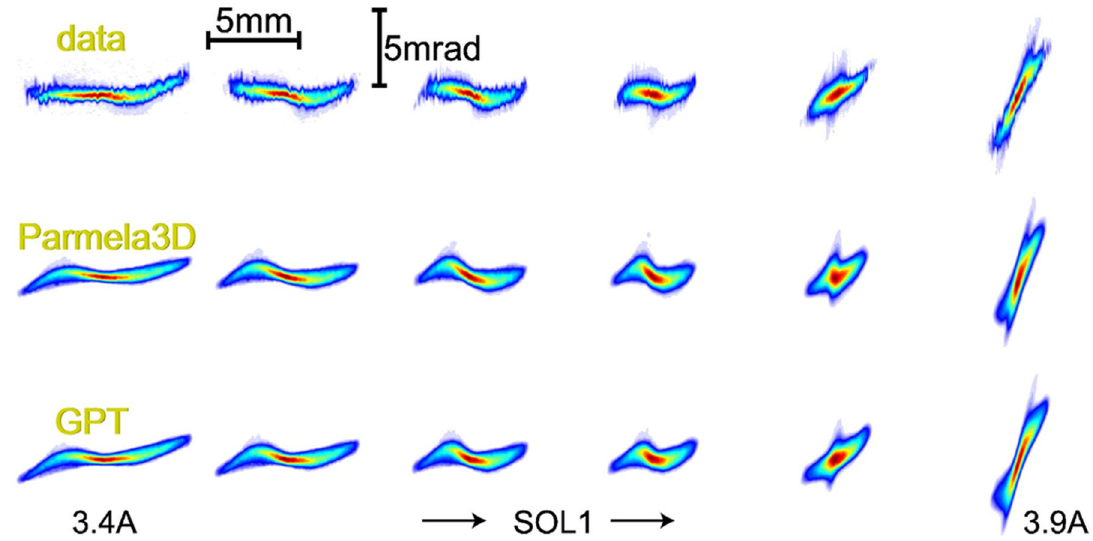
FIG. 14. (Color) Comparison of measured and simulated vertical transverse phase space distributions for 20 pC bunches at z ¼ 1 : 244 m . Data representing measurements, PARMELA3D , and GPT calculations are arranged in rows with different strength of the solenoid lens corresponding to column position.